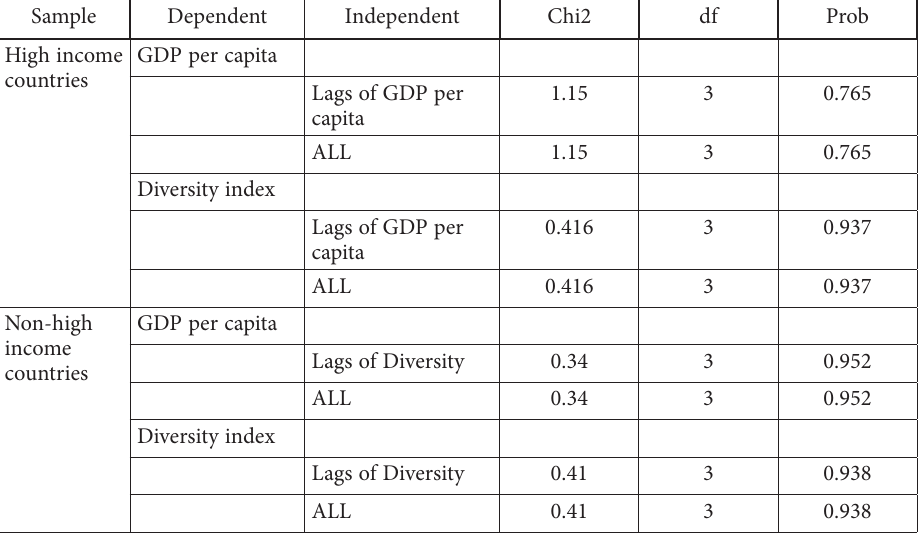
Table C.1. Granger causality test results for GDP per capita and diversity index